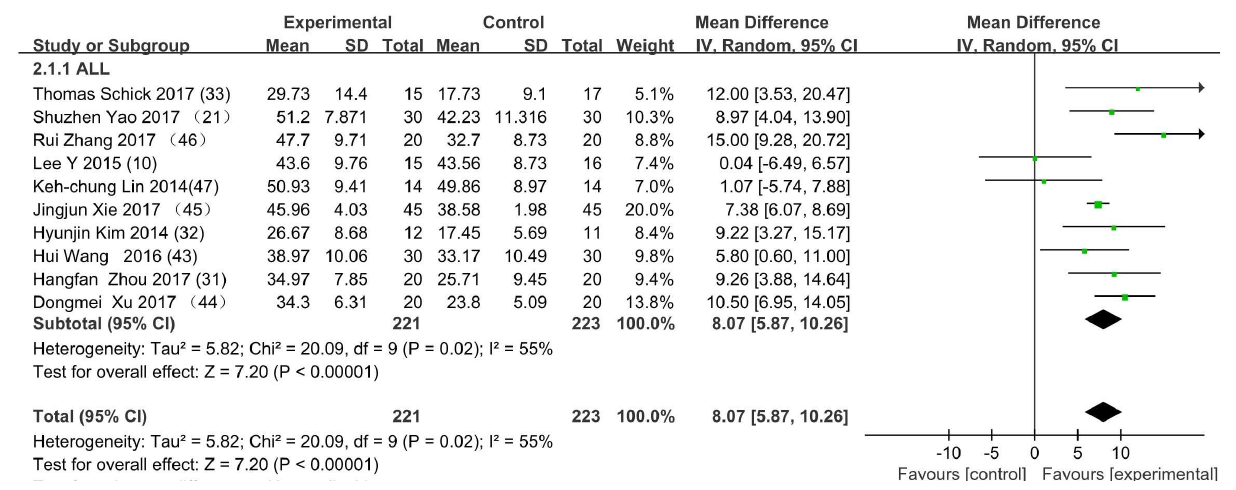
Frontiers in Neurology |